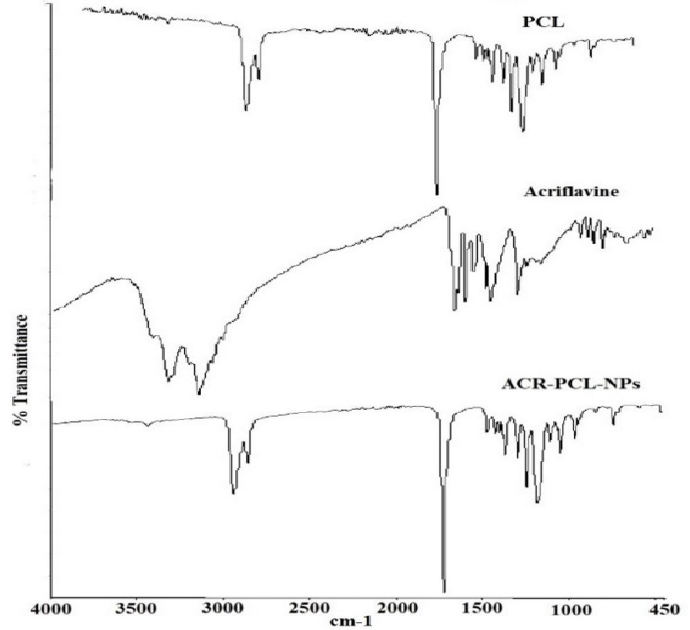
Figure 7. FTIR spectra of acriflavine, pure PCL, and prepared nanoparticles (ACR-PCL-NPs).